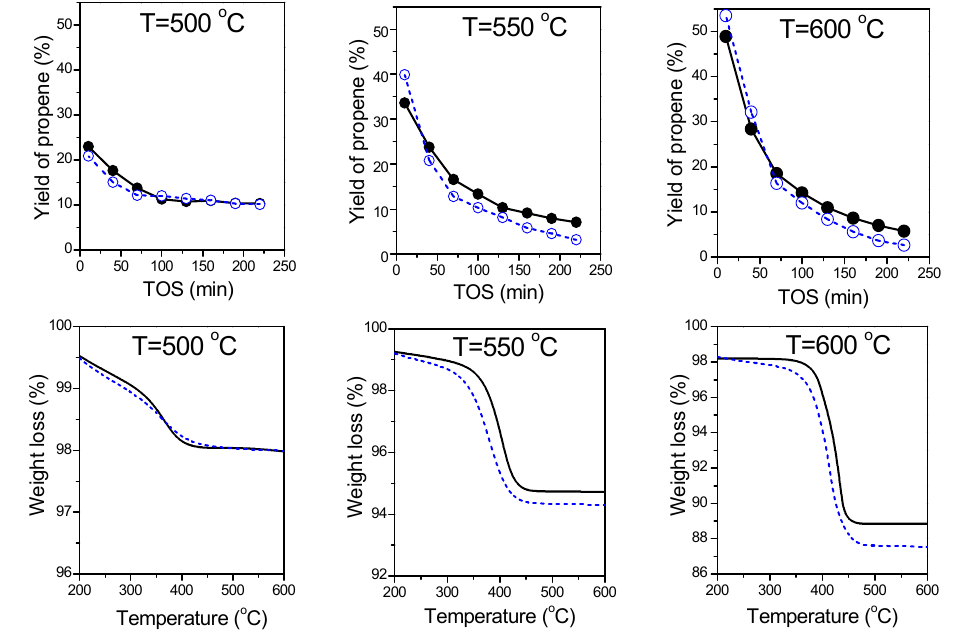
Figure 6. Comparison of Cr20/Al 2 O 3 -n (solid line) and Cr20/Al 2 O 3 -c (dot line) catalysts stability during PDH at 500. 550 and 600 ◦ C. Reaction conditions: m cat. = 200 mg; Feed gas composition C 3 H 8 :He =1:14; Total flow rate = 30 cm 3 · min − 1 ; WHSV = 1.2 h − 1 .